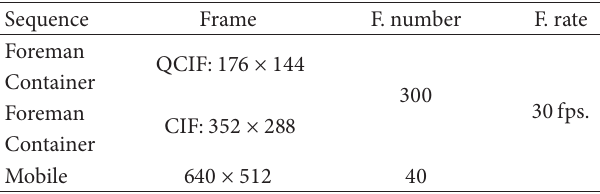
Table 3: Sequences included in the “test